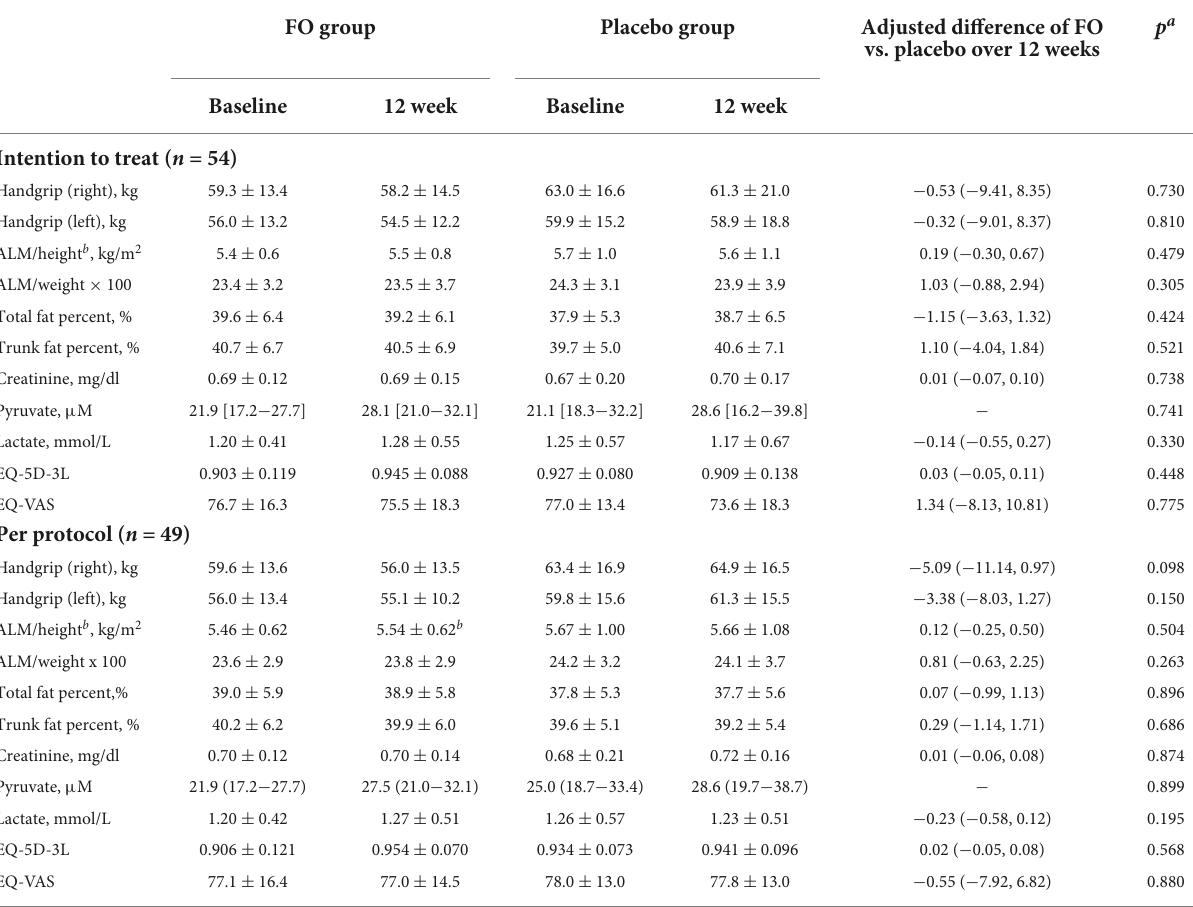
p a vs. placebo over 12 weeks